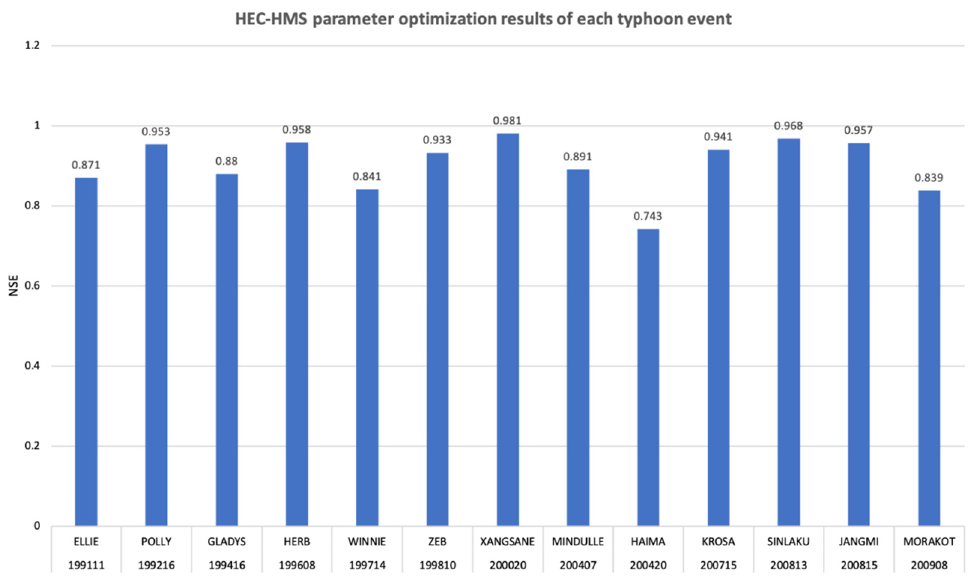
Figure 3. The NSE of the HEC-HMS model validation using a different parameter inference approach for each typhoon event.